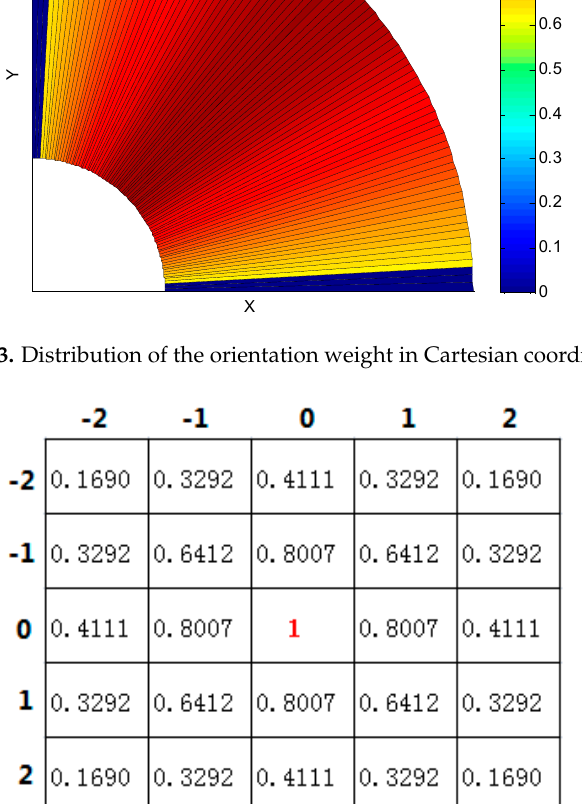
Figure 4. Distribution of Gaussian space weight.